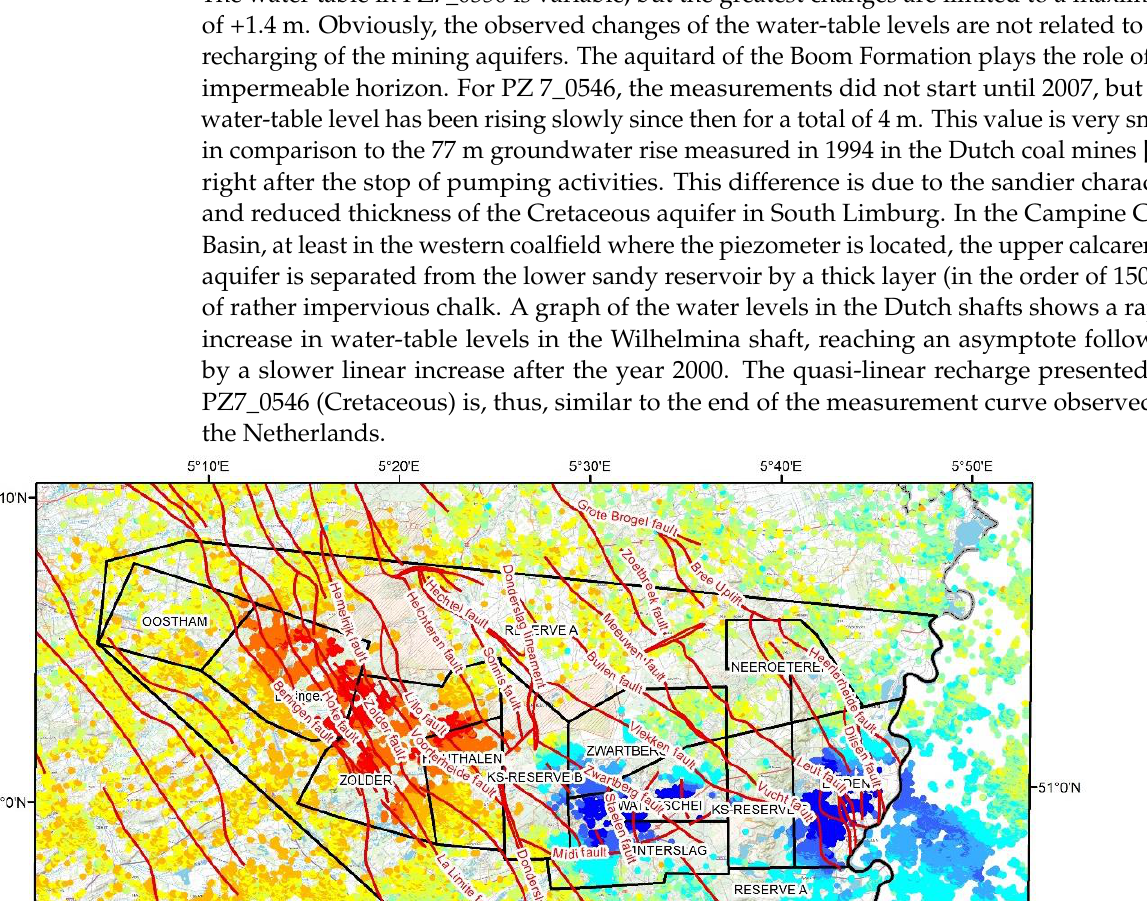
Figure 11. Color classification based on the average annual LOS-velocity values of PS points for ERS-1/2 (1992 – 2005), superimposed on the extension of coal concessions in Limburg and the major faults affecting the Paleozoic basement.